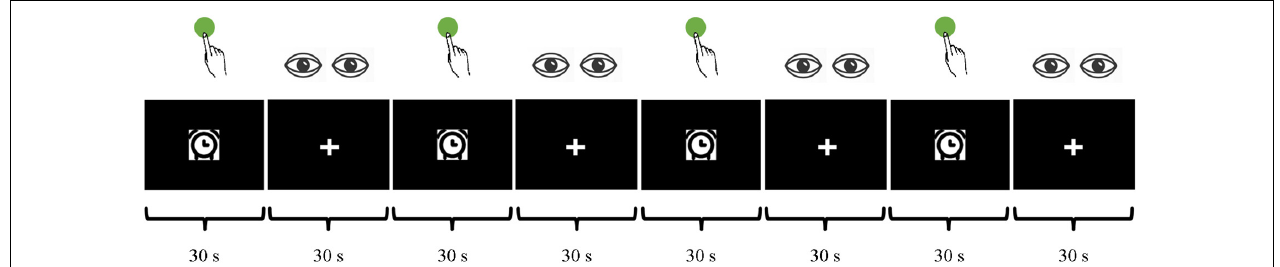
FIGURE 1 | Finger tapping, a block design task with a self-paced rhythm at around 2 s, during a 4-min MRI scan.